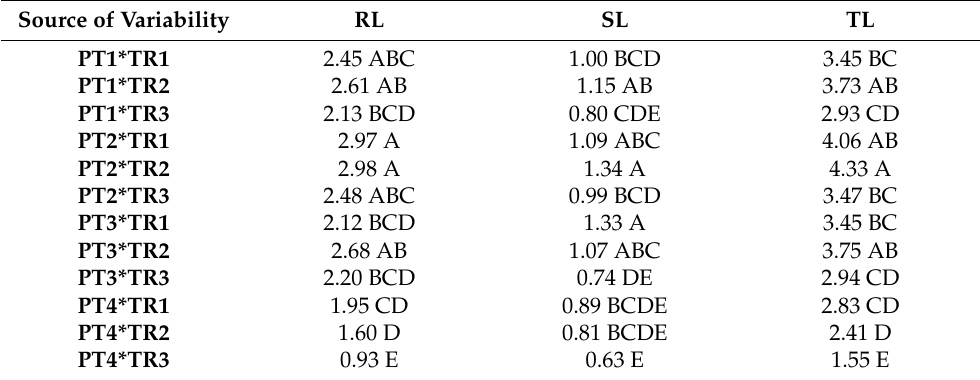
Table 7. Interaction effect of priming treatment and drought treatment of natural winter savory Population 1 morphological parameters in the second phase of the experiment. Source of Variability RL SL TL PT1*TR1 2.45 ABC 1.00 BCD